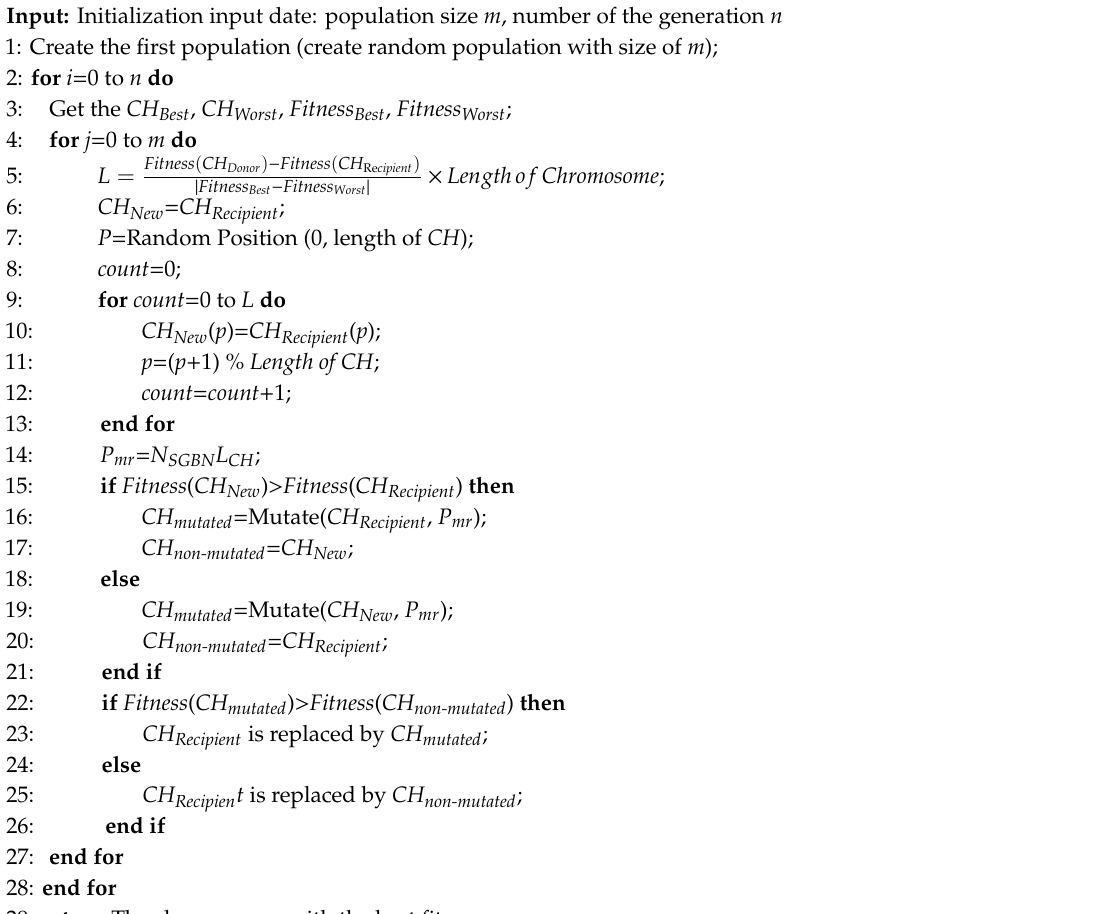
Algorithm 1 The online